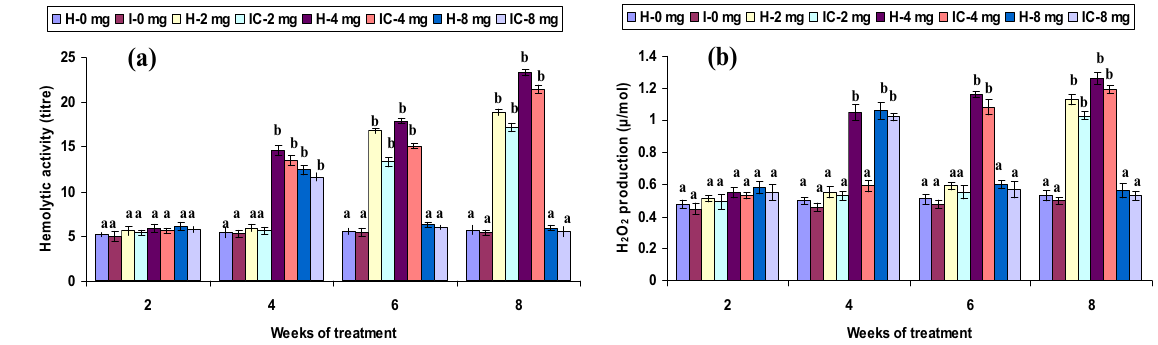
Figure 3. ( a ) Hemolytic activity and ( b ) hydrogen peroxide (H 2 O 2 ) production of catla (n = 6) head kidney leucocytes against A. hydrophila . H healthy, I infected. Data are expressed as mean ± SD and the statistically significant difference ( P < 0.05) between mean values as indicated in different letters in each column.